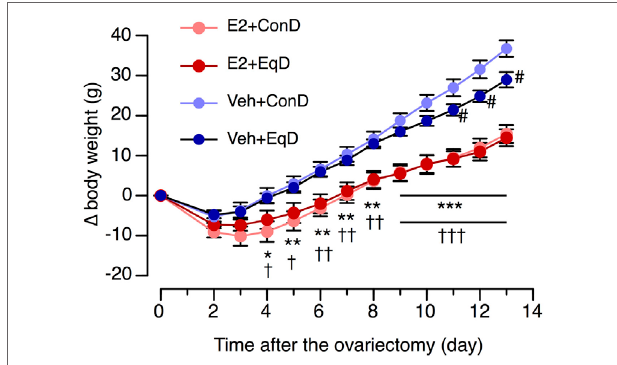
FigUre 1 | The effect of estradiol (E2) replacement and dietary S -equol on the time course of body weight change ( Δ body weight) from the day of ovariectomy in ovariectomized rats. Rats were ovariectomized and assigned to the E2-replaced or cholesterol [vehicle (Veh)]-treated group. These rats were fed a standard (control) diet (ConD) or an S -equol-containing diet (EqD). Values are shown as the mean ± SEM ( n = 10 in E2 + ConD; n = 10 in E2 + EqD; n = 11 in Veh + ConD; n = 12 in Veh-EqD). *, **, and ***, significant differences ( P < 0.05, P < 0.01, and P < 0.001, respectively) between the E2 + ConD and Veh + ConD groups. † , †† , and ††† , significant differences ( P < 0.05, P < 0.01, and P < 0.001, respectively) between the E2 + EqD and Veh + EqD groups. # , significant differences ( P < 0.05) between the Veh + ConD and Veh + EqD